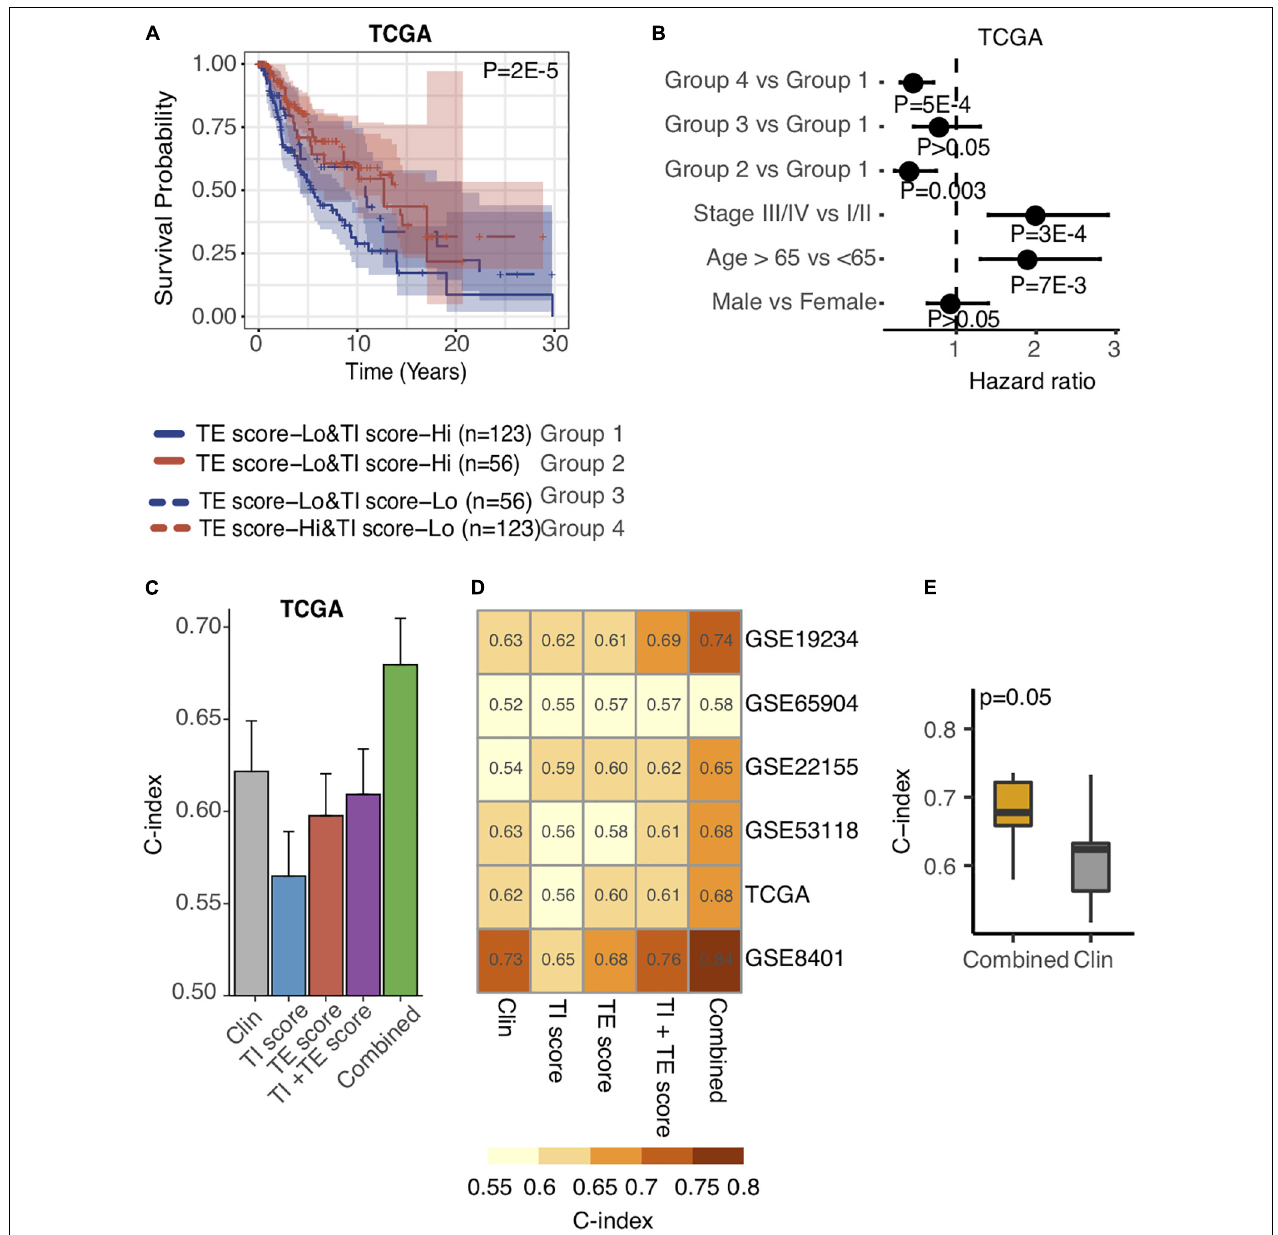
FIGURE 5 | Integration of TE signature and TI signature outperforms prognosis prediction than clinical factors. (A) Kaplan–Meier plots depicting the survival distribution for patients in each group. In Kaplan–Meier plots, p -values were calculated using the log-rank test, and vertical hash marks indicate censored data. (B) Forest plot showing hazard ratios and p -values of TE-signature score and several clinical variables estimated by a multivariate Cox regression model. In all forest plots, HR was presented as the 95% confidence interval, the dotted lines indicate the null association, and the Wald’s test was used to determine statistical significance. (C) Barplot showing the C-index distribution of using Clinical factors, TI-signature scores, TE-signature scores, combination of TI-signature and TE-signature scores, and combination of all features in predicting prognosis in TCGA data. (D) Heat map showing the C-index distribution of features listed in (C) across different datasets. (E) Boxplot showing the C-index difference between combined prognostic model and clinical factor-derived prognostic model. P -value was calculated by the Wilcoxon rank-sum